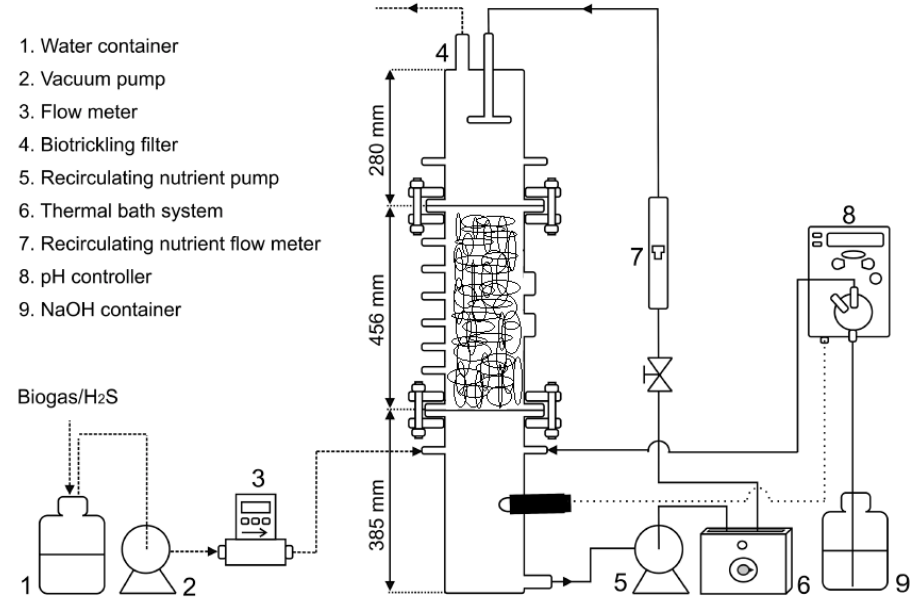
Figure 3. Representation of the biotrickling filter, adapted from Guerrero and Bevilaqua [19].